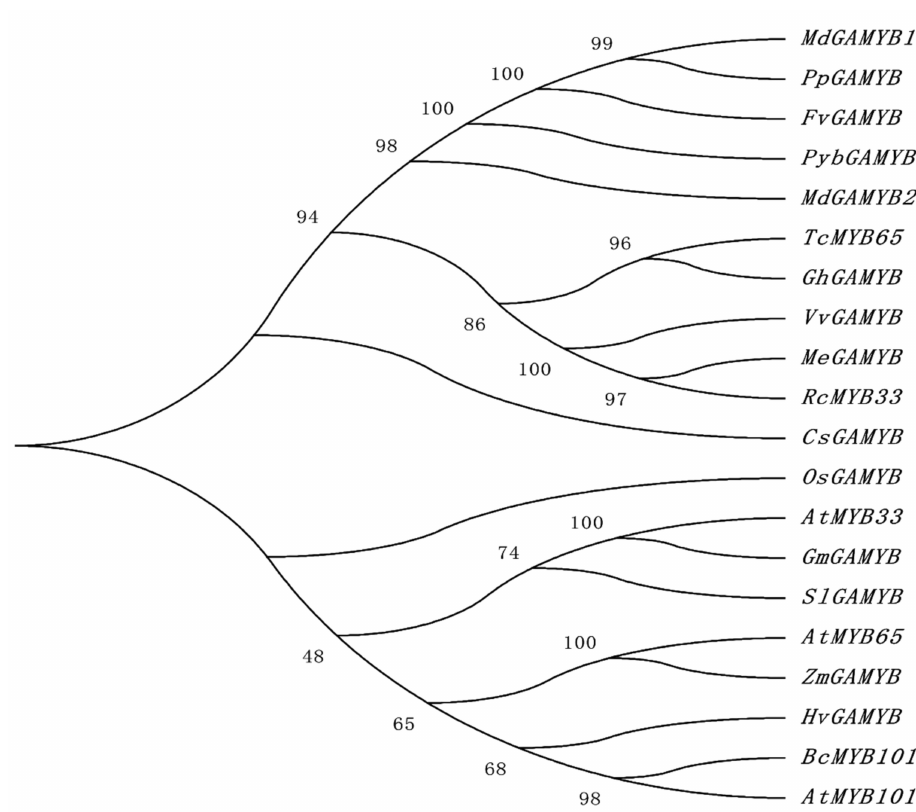
Figure 2. Phylogenetic analysis of GAMYB genes in diverse species. The phylogenetic relationship of GAMYB was constructed using MEGA7 software with 1000 bootstrap replications. In addition to the nine species used in multiple sequence alignment, Malus domestica ( Md ), Fragaria vesca ( Fv ), Manihot esculenta ( Me ), Ricinus communis ( Rc ), Populus euphratica ( Pe ), Glycine max ( Gm ), Cucumis sativus ( Cs ), Pyrus × bretschneideri ( Pyb ), and Prunus persica ( Pp ) were added to the construction of the phylogenetic